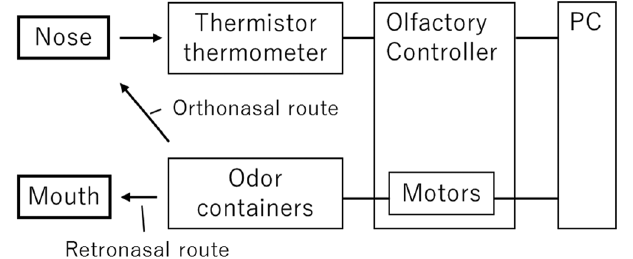
Figure 1. System configuration of the